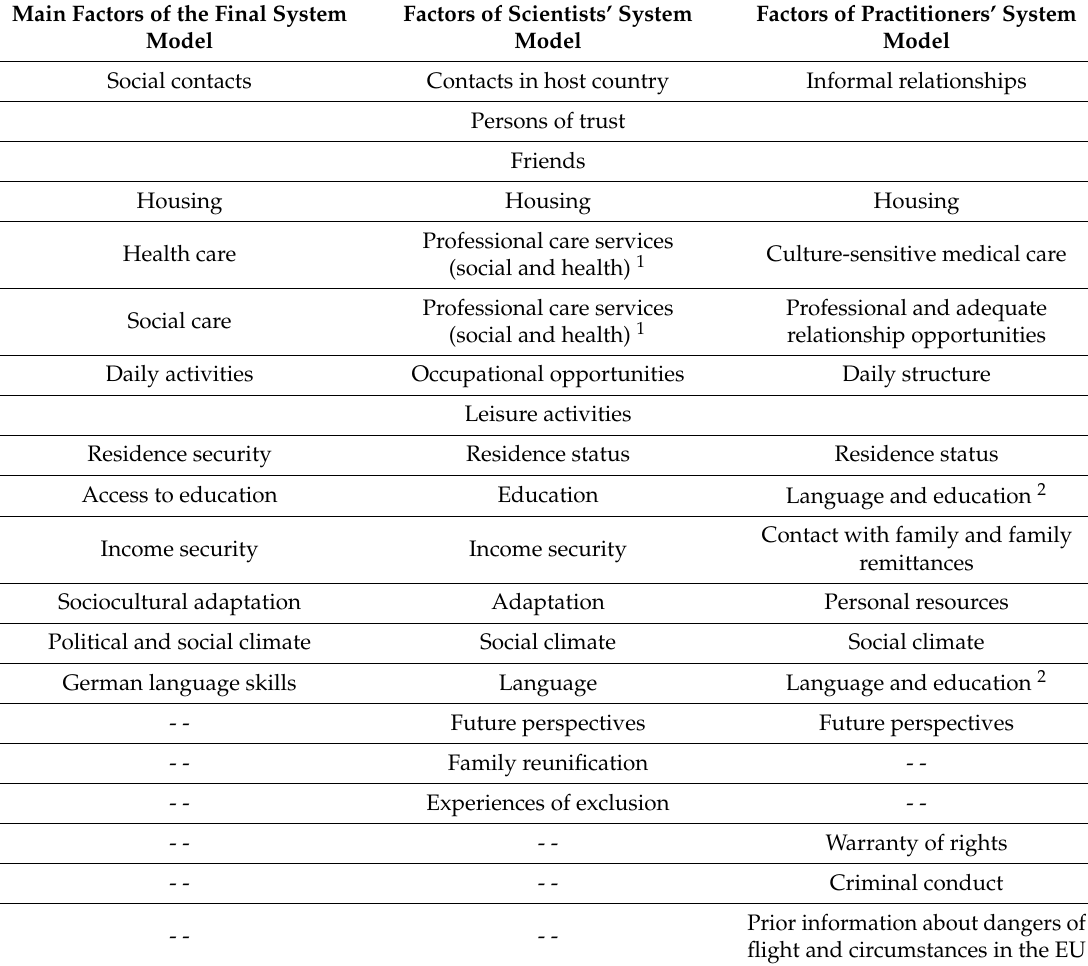
Table 2. Clustered post-migration risk factors identified in the three